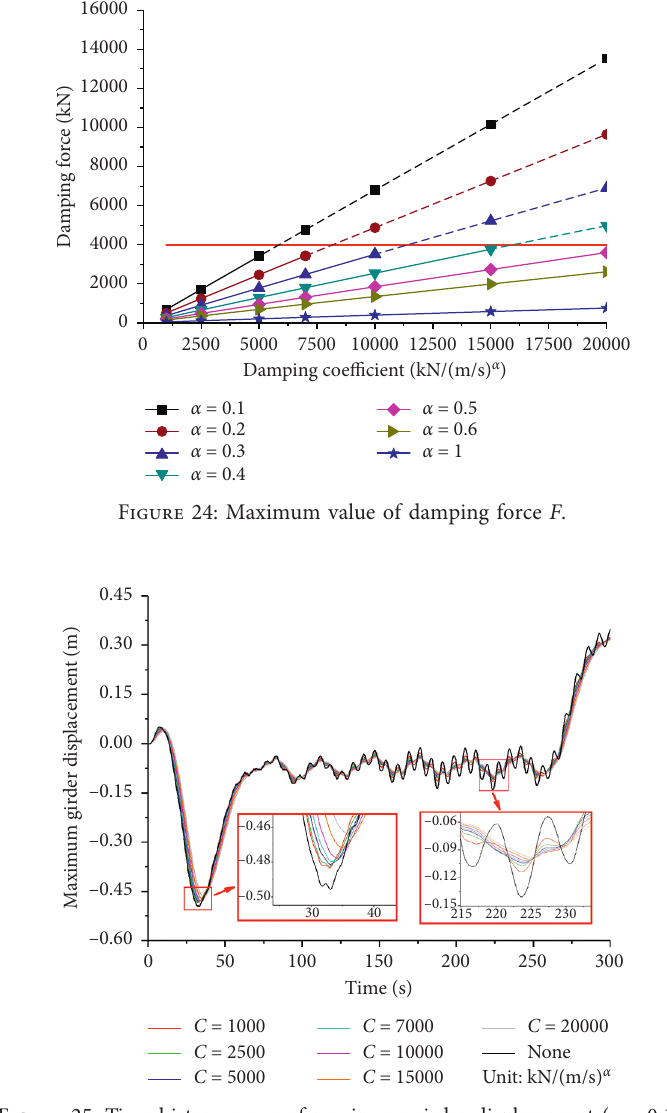
Figure 25: Time history curve of maximum girder displacement ( α � 0 . 1).